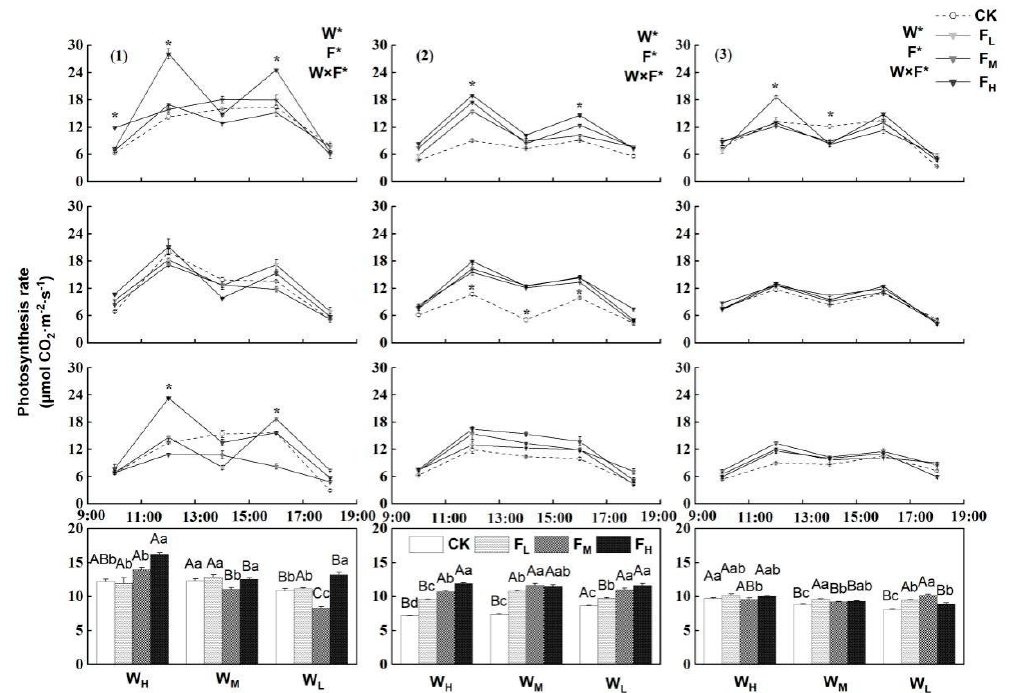
Figure 1. Changes in P n values of test plant species under different water–fertilizer treatments. Numbers ( 1 ) − ( 3 ) in brackets indicate P. crymophila, F. coelestis , and S. purpurea , respectively. W, F, and W × F indicate the results of ANOVAs ( p < 0.05) for the effects of water, fertilizer, and their interactions. Asterisk (*) and ns indicate significant difference and non-significant. The uppercase letters and lowercase letters represent the difference between water and fertilizer treatments.